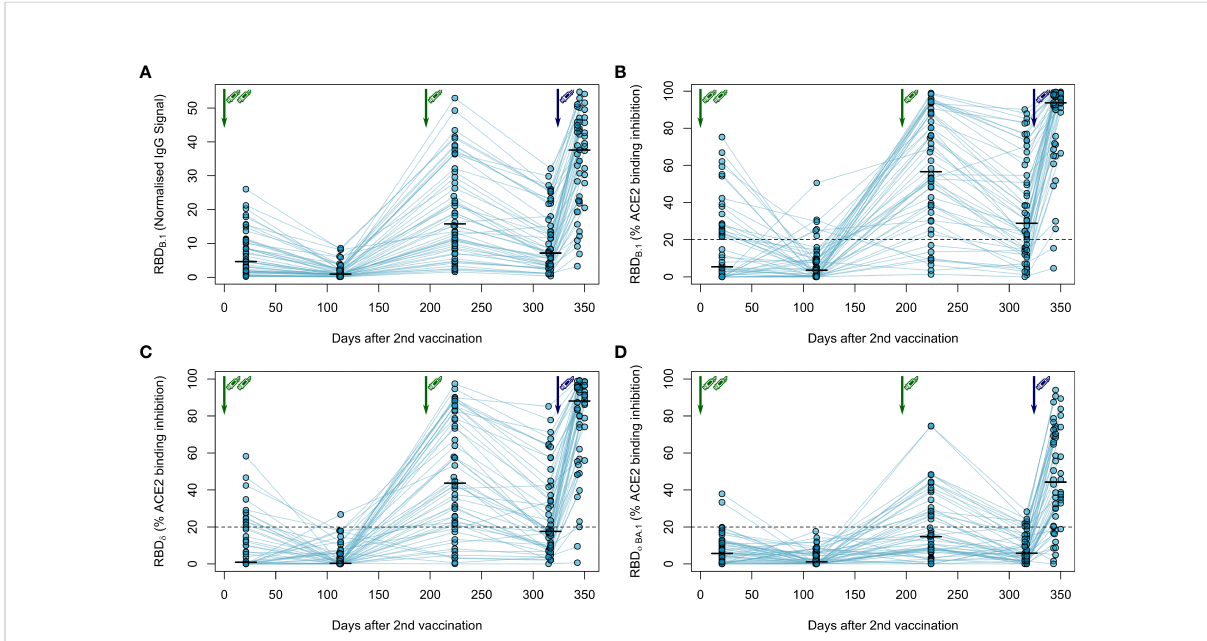
FIGURE 3 Longitudinal humoral immune response in haemodialysis patients after a triple vaccination with BNT162b2 and a fourth full-dose of mRNA- 1273. IgG response (A) and ACE2 binding inhibition (B – D) towards the SARS-CoV-2 RBD of B.1 (A, B) , d (C) and Ο BA.1 (D) isolates were measured in plasma from haemodialysis patients (n = 50) using MULTICOV-AB (A) or an ACE2-RBD competition assay (B – D) after immunisation with a triple dose of BNT162b2 (green syringe) and a fourth full-dose of mRNA-1273 (blue syringe). Data is displayed as normalised median fl uorescence intensity (MFI) signal for IgG binding (A) or as % ACE2 binding inhibition where 100% indicates maximum inhibition and 0% no inhibition (B – D) . Samples with an ACE2 binding inhibition of less than 20% (dashed line) are classi fi ed as non-responders (B – D) . Interconnecting lines represent samples from the same individual. Sampling time points in days after the standard complete two-dose BNT162b2 vaccination is stated below the graph. Statistical signi fi cance was calculated by two-sided paired Wilcoxon rank test. Signi fi cance was de fi ned as p < 0.05. All p-values for relevant comparisons are listed in Table